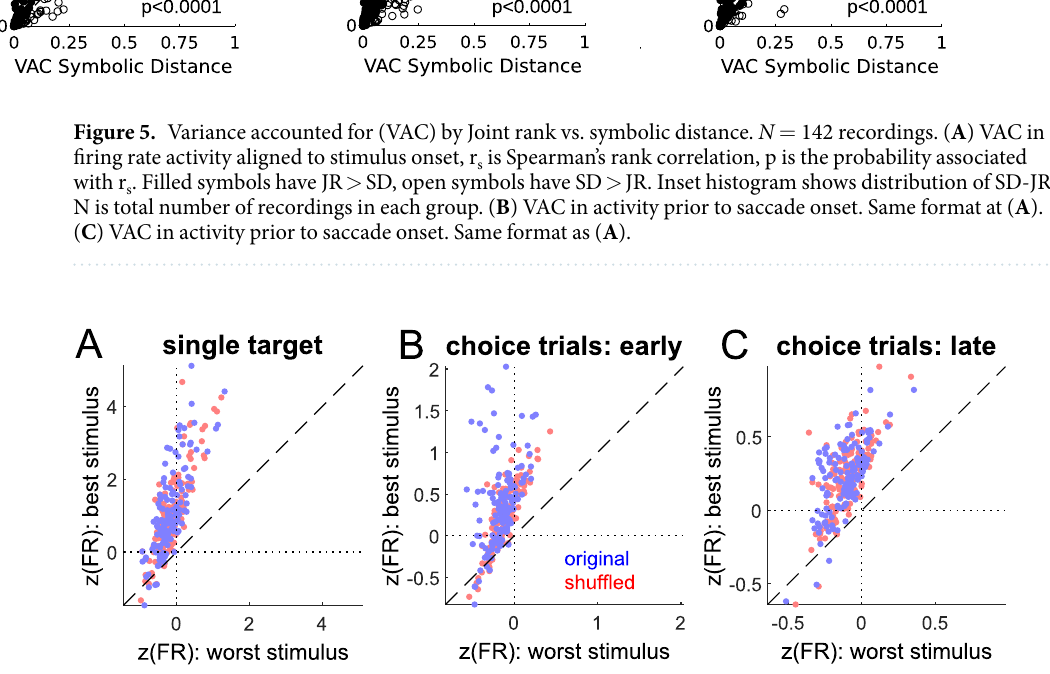
Figure 6. Encoding of stimulus identity. n = 142 recordings with 7-items lists. ( A ) Trials with a single stimulus in RF. Mean z -scored firing rate for best vs. worst stimulus during visual epoch using original stimulus labels (blue) and shuffled labels (red). ( B ) z -scored firing rate during visual epoch of first 250 choice trials with best vs. worst stimulus inside RF. Blue dots are responses with original labels, red dots are responses with shuffled labels. ( C ) Same as ( B ), but for choice trials after trial